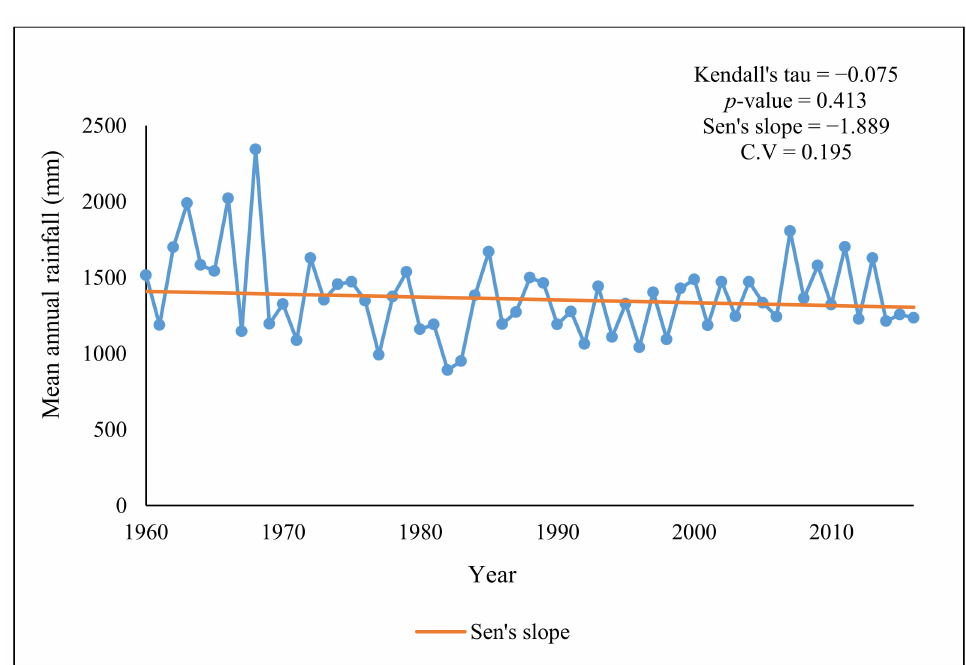
Figure 2. Mean annual rainfall pattern in study area, 1960–2016. Source: Data obtained from Council for Scientific and Industrial Research.